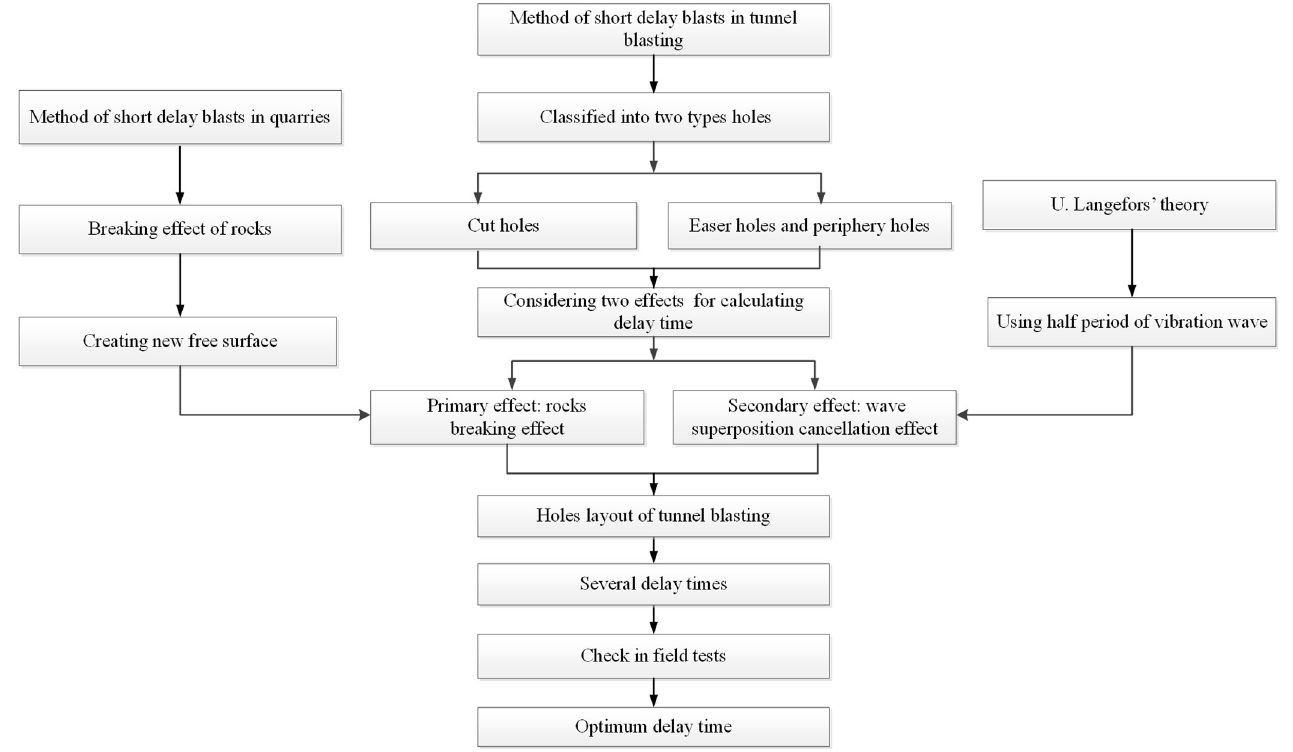
Fig 1. Block diagram of the method of delay time for tunnel